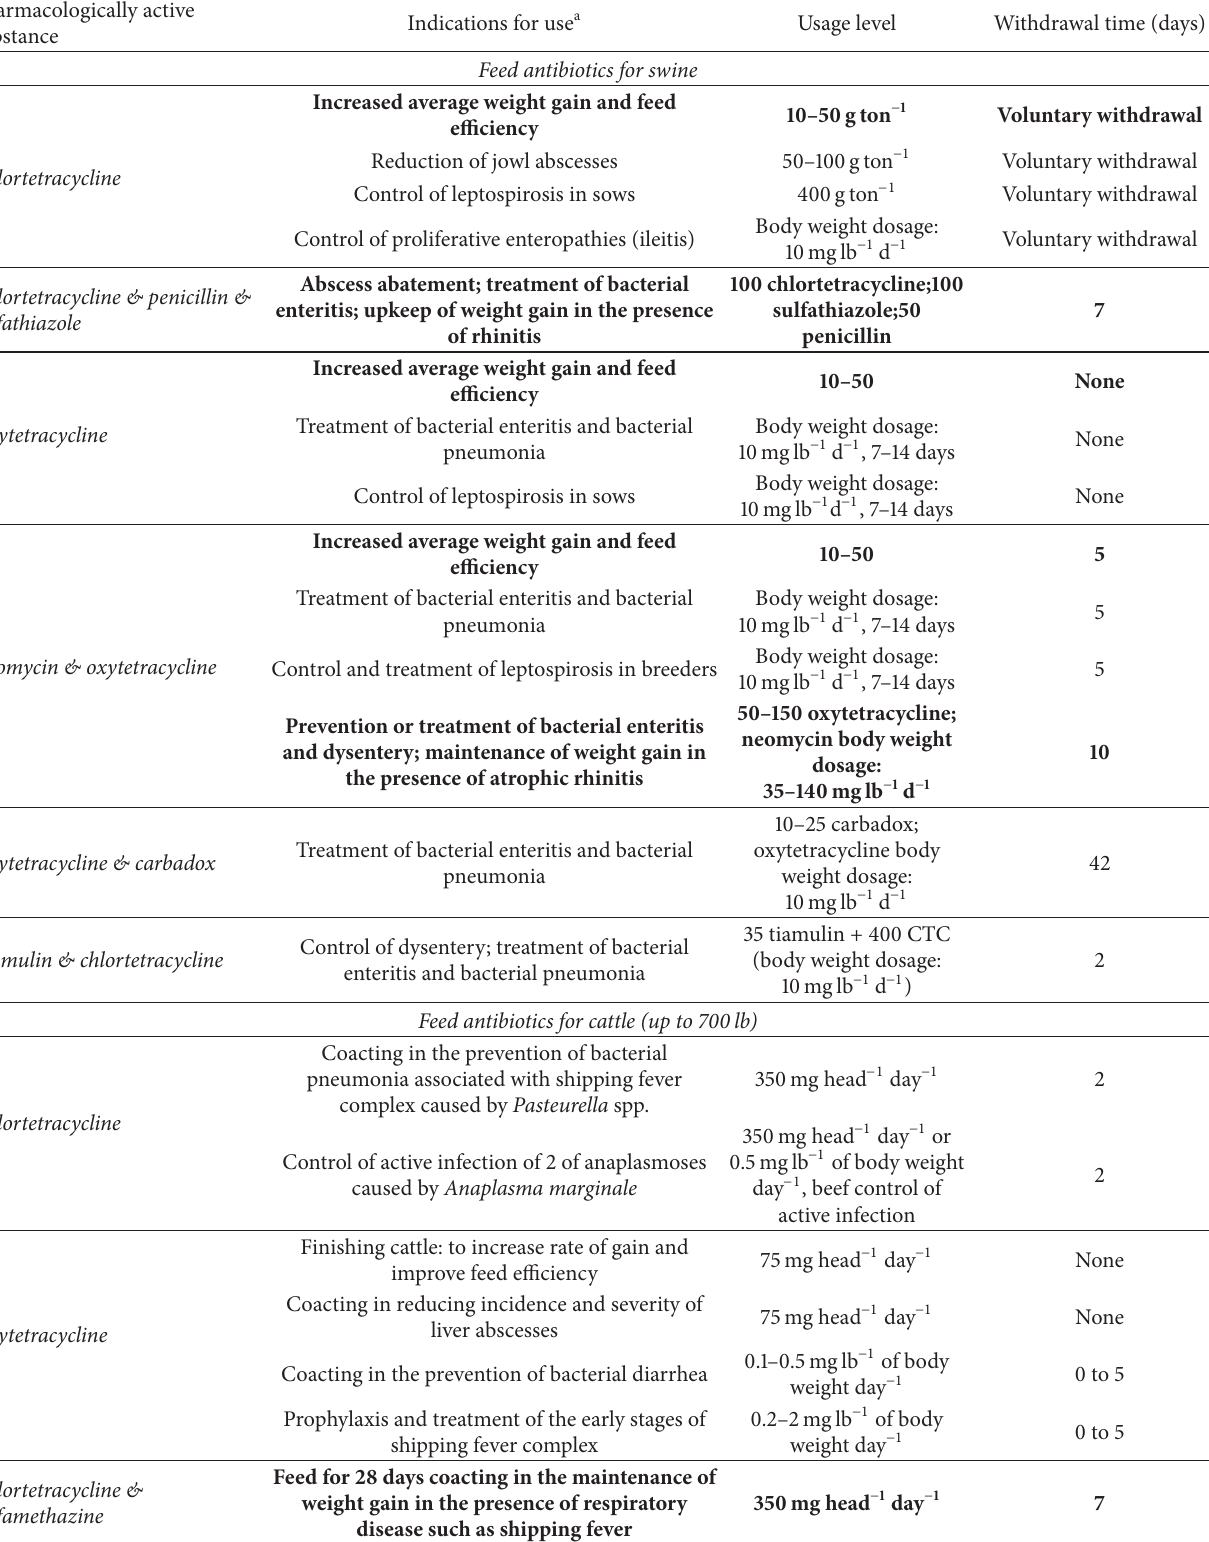
Table 1: Approved applications of tetracyclines in medicated feed for different food-producing animal species and their respective withdrawal time